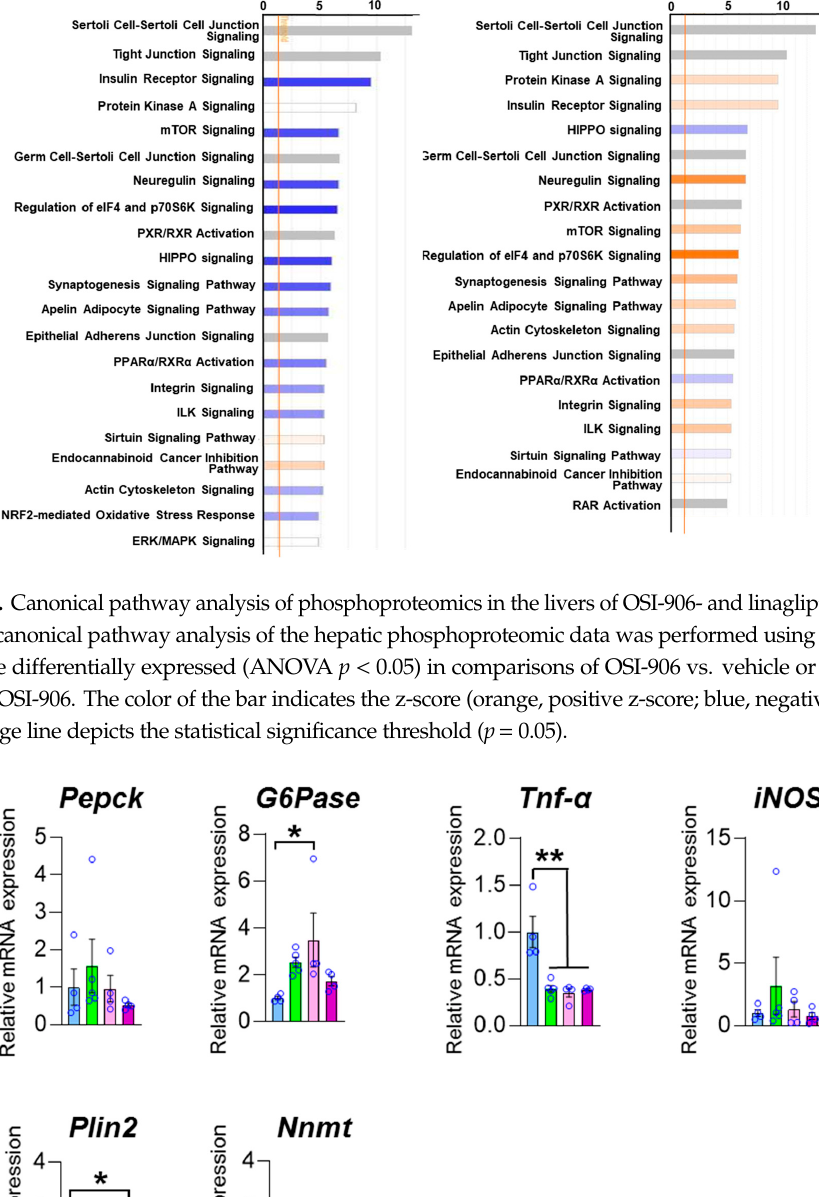
Figure 6. Canonical pathway analysis of proteomics in the livers of OSI-906- and linagliptin-treated mice. A canonical pathway analysis of the hepatic proteomic data was performed using molecules that were differentially expressed (ANOVA p < 0.05) in comparisons of OSI-906 vs. vehicle and OSI- 906 + Lina vs. OSI-906. The color of the bar indicates the z-score (orange, positive z-score; blue, negative z-score). The orange line depicts the statistical significance threshold ( p = 0.05).